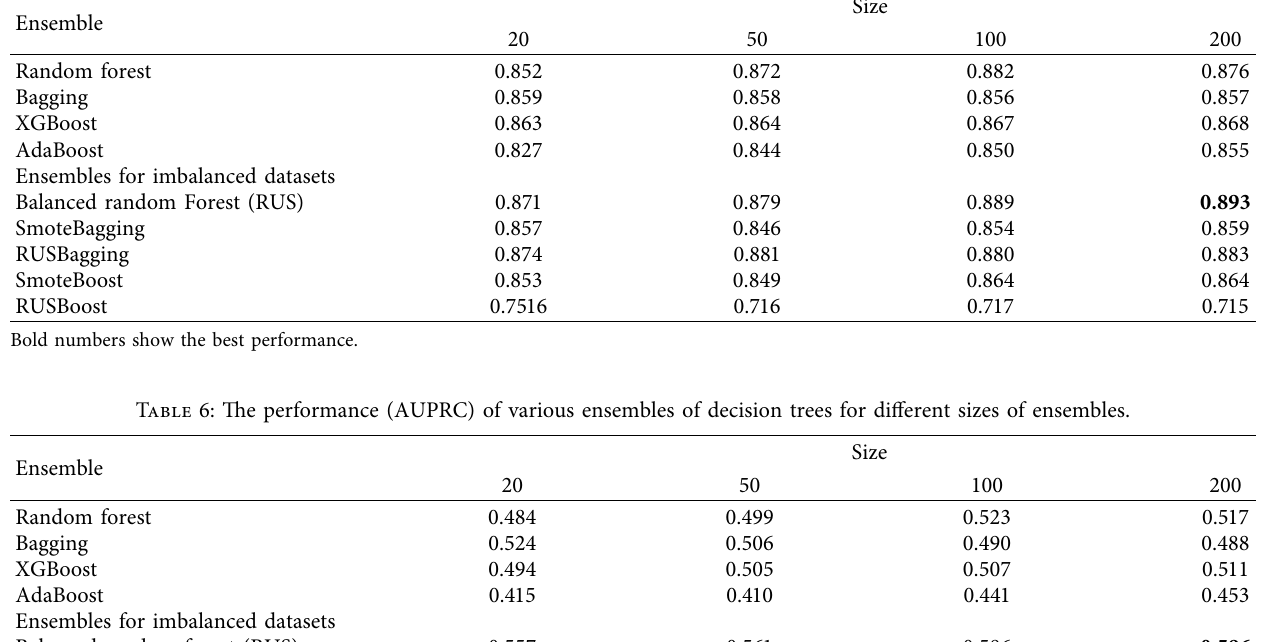
Table 5: The performance (AUROC) of various ensembles of decision trees for different sizes of ensembles.